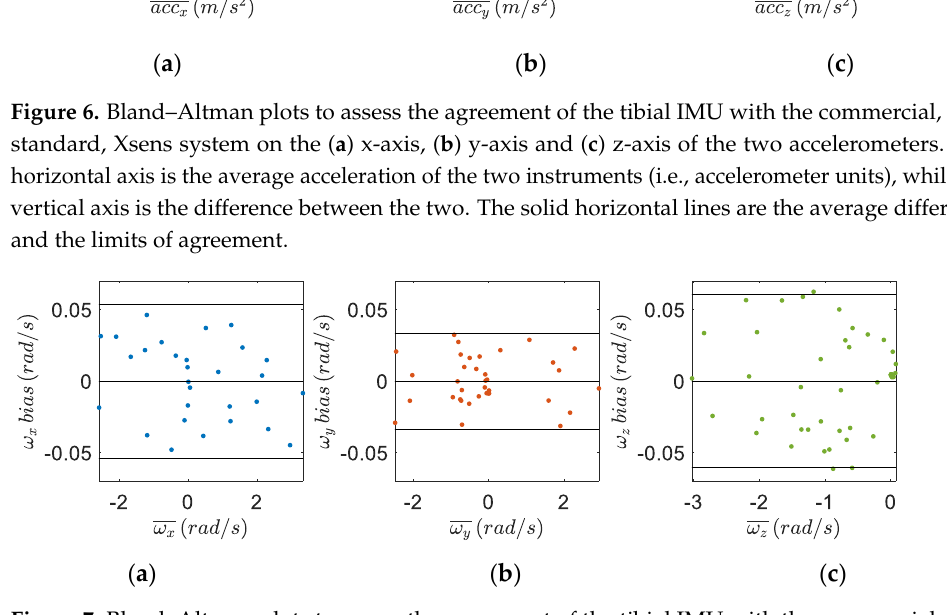
Figure 7. Bland – Altman plots to assess the agreement of the tibial IMU with the commercial, gold standard, Xsens system on the ( a ) x-axis, ( b ) y-axis and ( c ) z-axis of the two gyroscopes. The horizontal axis is the average angular velocity of the two instruments (gyroscopes units), while the vertical axis is the difference between the two. The solid horizontal lines are the average difference and the limits of agreement.